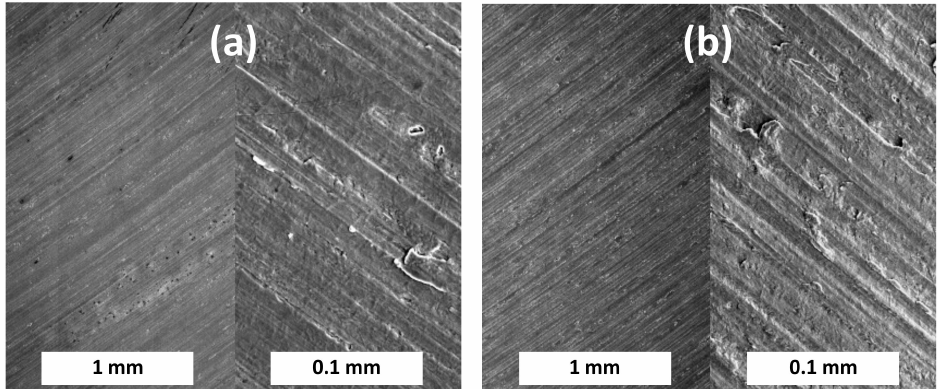
Figure 24. Scanning electron microscopy images of surfaces that have been produced by procedure # 2 (see Table 4 and compare to Figure 23b) with ( a ) a preceding heat treatment of 980 ◦ C/0.5 h and subsequent air quenching; and ( b ) 980 ◦ C/0.5 h, air quenching, and 630 ◦ C/2